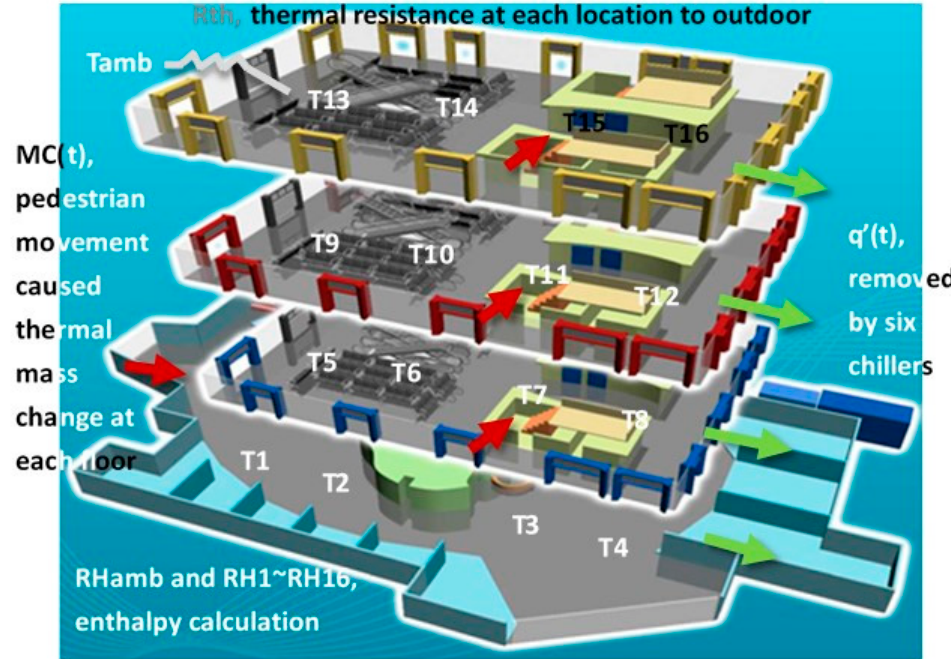
Figure 3. The test site simulation and related parameters for building a control model.